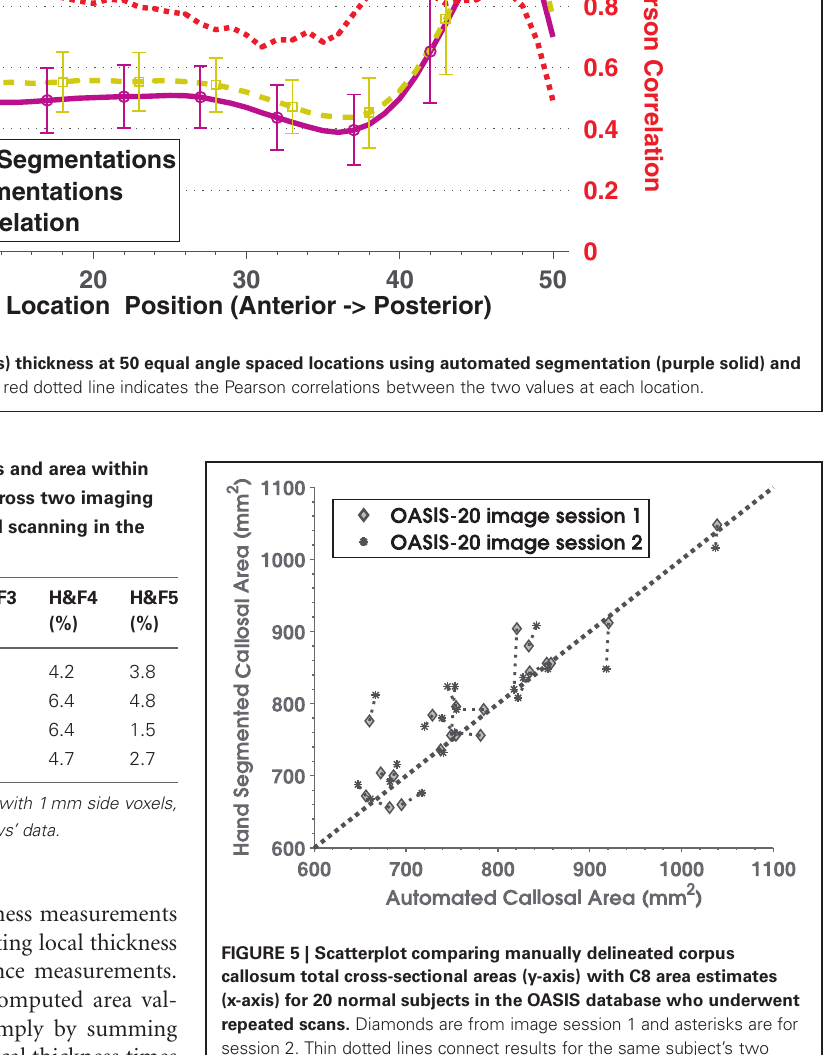
were similar across sites although the mid-body values had higher relative